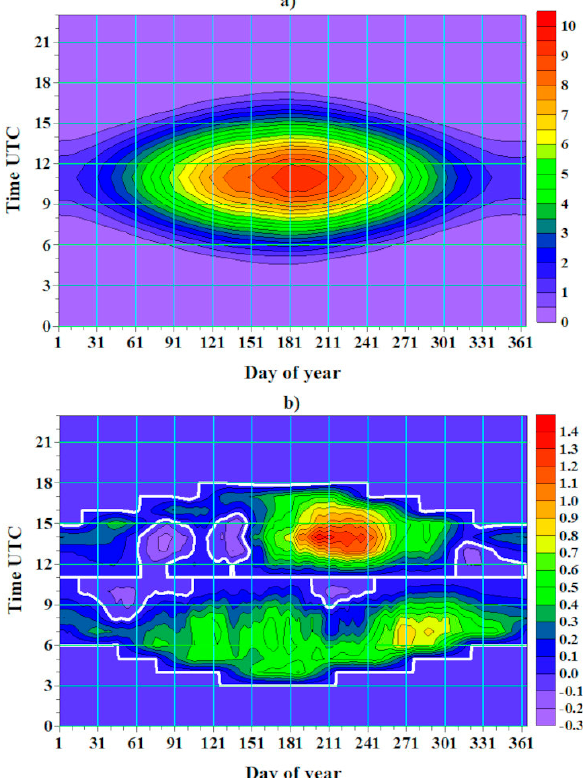
Figure 7. ( a ) Diurnal and seasonal behavior of the UV-Index in clear weather using the theoretical dependence on the square of the cosine of the zenith angle of the Sun and ( b ) the differences from the empirically determined values for hours different from 11 UTC. The zero line is marked with white color.